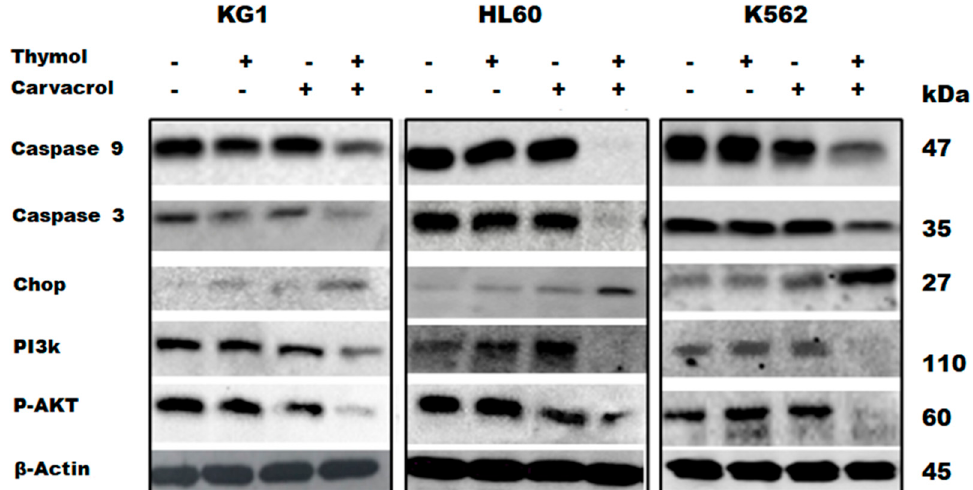
Figure 8. Effect of carvacrol and thymol combination in cell death induction through apoptotic and cell stress pathways. Western blot (WB) of caspase-3, caspase-9, CHOP, PI3k, pAKT, and B actin expression following carvacrol and thymol treatment (individually or in combination). A representative figure of WB results from three independent experiments is presented.